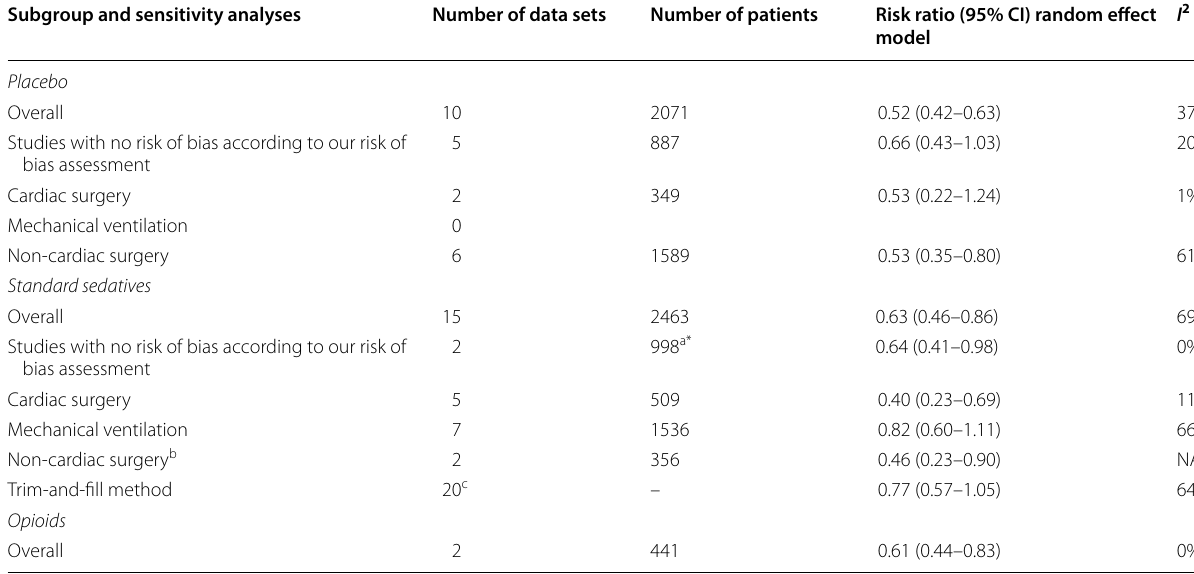
Table 3 Subgroup and sensitivity analyses for incidence of delirium